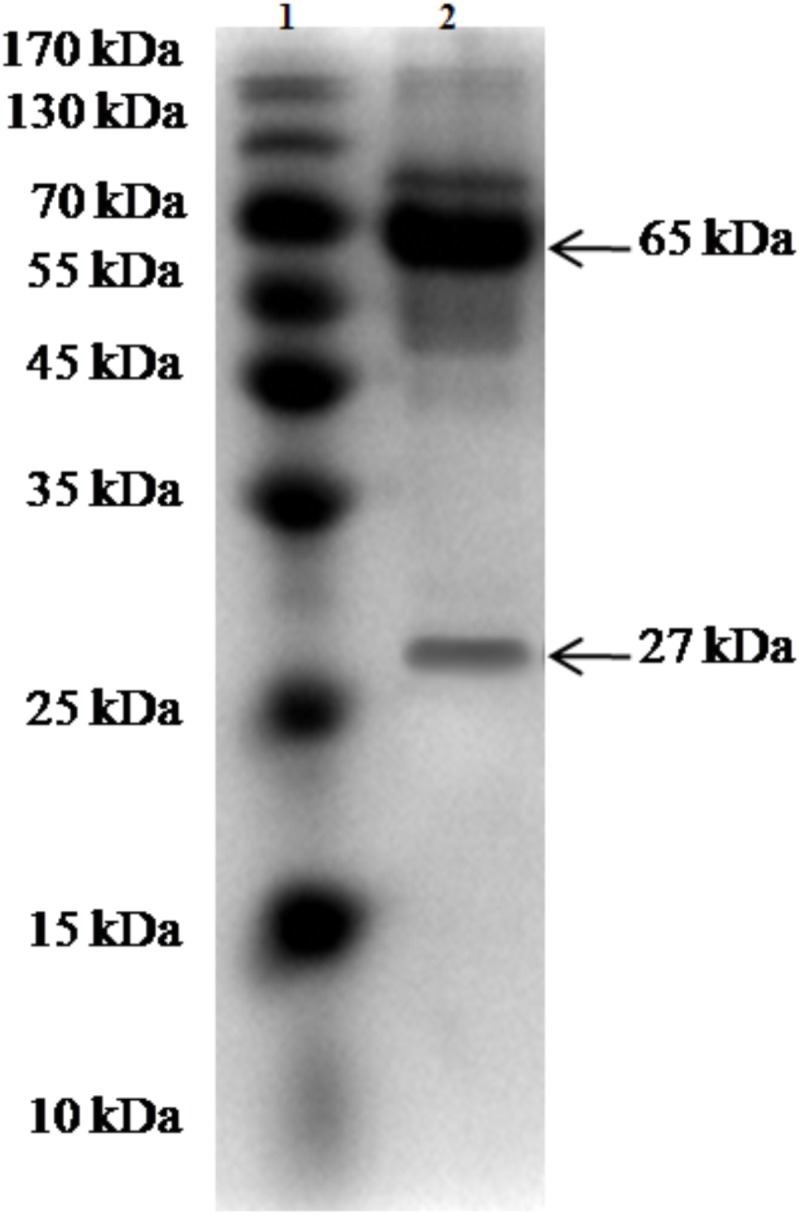
SDS-PAGE of the purified IgY for CSBV. Lane 1: Protein marker and Lane 2: Purity of IgY.